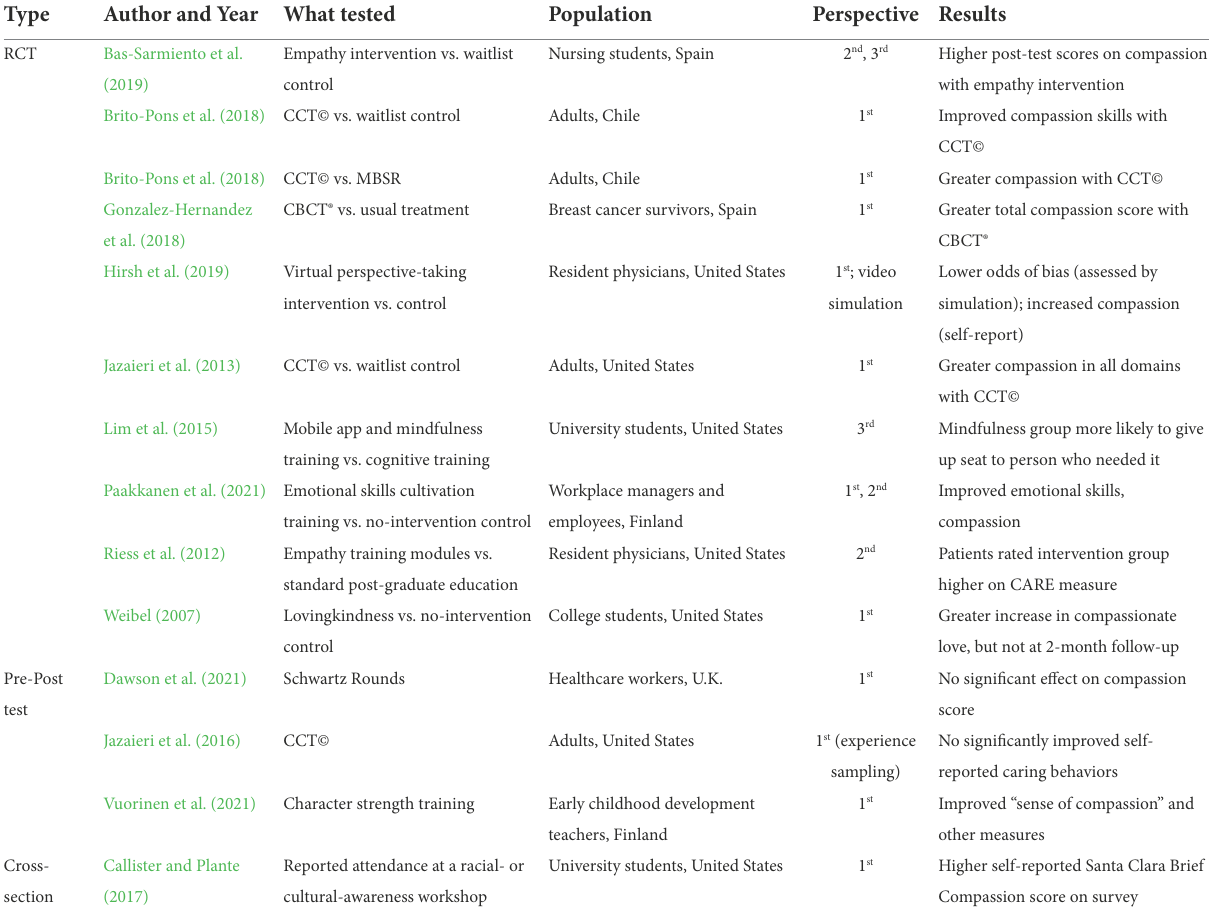
TABLE 4 Characteristics of studies that assessed a training intervention to promote